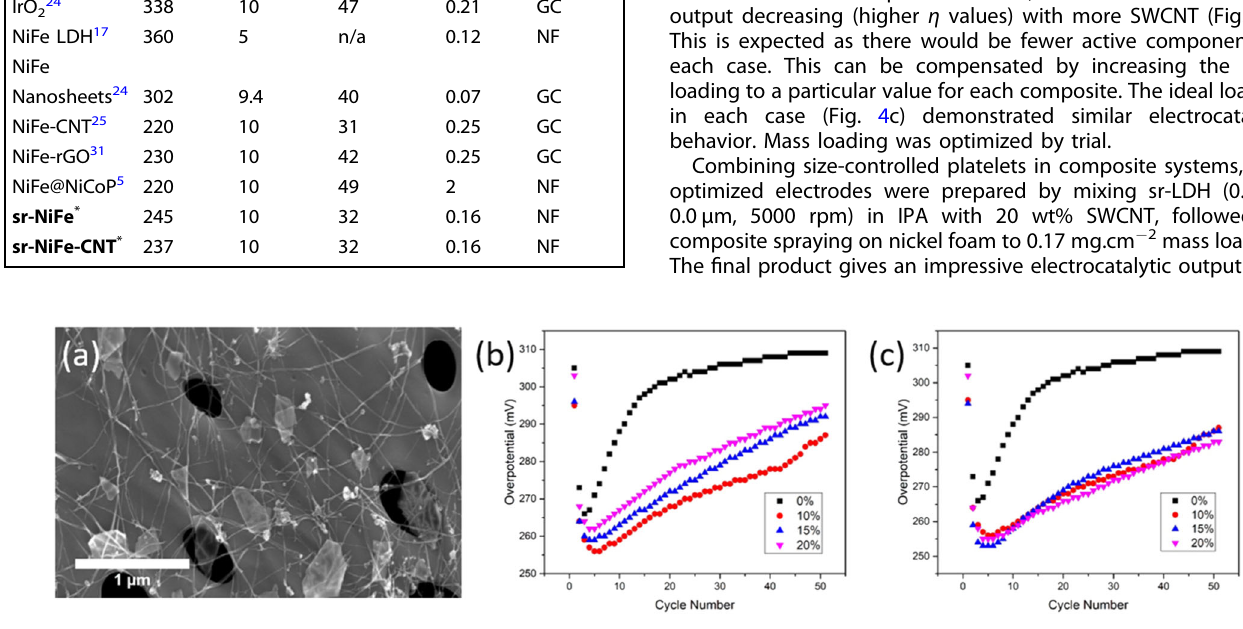
Fig. 4 Optimization of integrated composite materials. a SEM of sr-NiFe-SWCNT composite on lacey carbon and b comparison of overpotentials through 50 cycles of OER electrodes prepared using sr-NiFe with 10, 15, and 20 weight % SWCNT with identical mass loading and c optimized mass loading. Scale bar is 1 μ m in a .